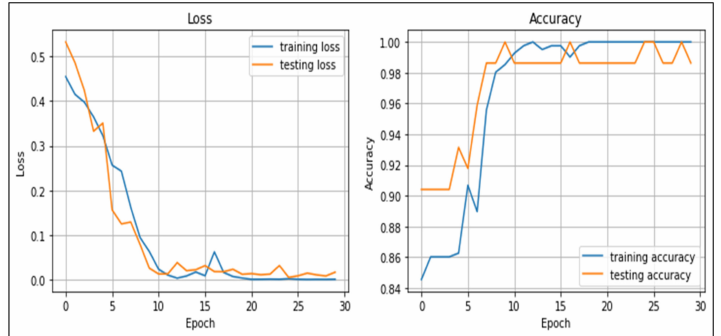
Figure 9. ( Left ) Training and testing loss. ( Right ) Training and testing accuracy.